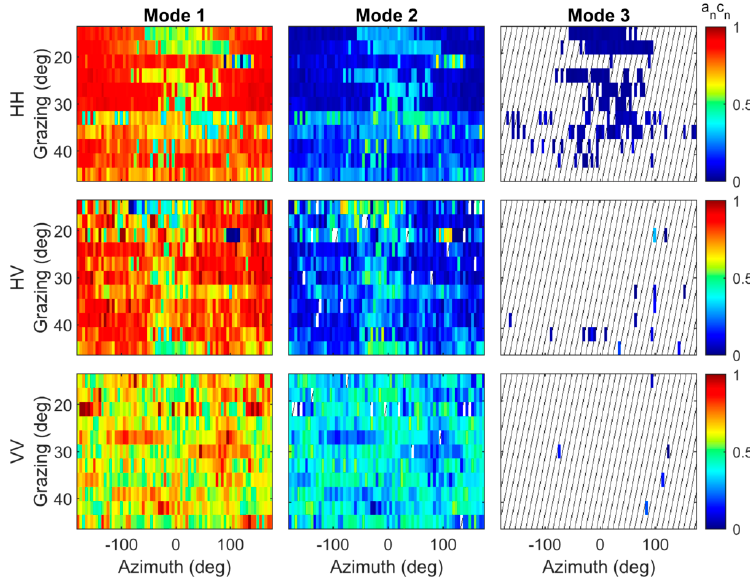
Figure 13. 3MD distribution parameters ( (cid:1853) (cid:3041) (cid:1855) (cid:3041) ) for the INGARA dataset, Run 3.